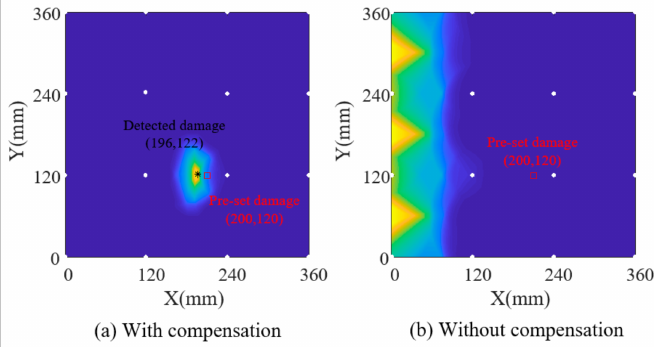
Figure 9. Damage identification results of simulation model 2.